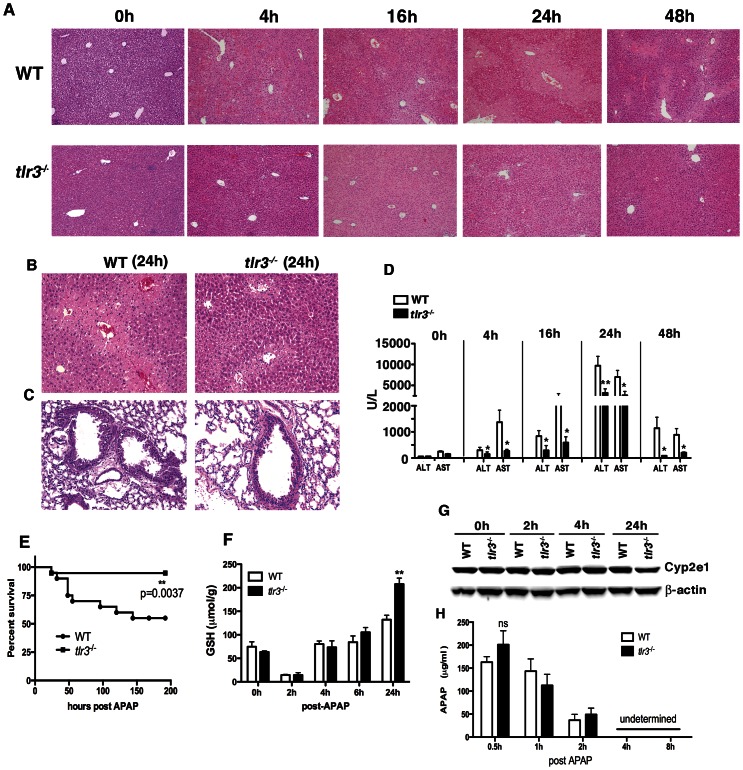

Tlr3
−/− mice exhibit markedly less hepatotoxicity following APAP.(A–B) Representative histological liver samples from WT and tlr3
−/− mice after APAP. (C) Lung sections from WT mice at 24 h post APAP. Original magnifications: (A) 100× or (B–C) 200×. (A–C). Data from 4 and 16 h after APAP are representative of 2 independent experiments (n = 5 mice/group). Data from 24 h after APAP are representative of 5 independent experiments (n = 5 mice/group), and data from 48 h post APAP is representative of 3 independent experiments (n = 4–9 mice/group). (D) Serum ALT and AST levels were measured at various time points after APAP. Values represent mean±SEM obtained from 2–3 independent experiments (n = 4–5 per group) (*p<0.05; **p<0.01). (E) Survival of WT and tlr3
−/− mice after 500 mg/kg of APAP. The data are from 2 independent experiments. Each experiment was performed with 10 WT mice and 9–10 tlr3
−/− mice. **p = 0.0037 (Mantel-Cox test). (F) Hepatic GSH levels after APAP injection (n = 3–4 mice/group). Values represent means±SEM of 2 independent experiments. **p<0.01 when tlr3
−/− was compared with WT mice. (G) Liver lysates of WT and tlr3
−/− mice were prepared and pooled for Western blotting analysis using anti-Cyp2e1 and β-actin antibodies. (H) Concentration of APAP was determined in serum from WT and tlr3
−/− at the indicated time points. Values indicate mean ± SEM of 5–6 individual mice. ns = not significant.